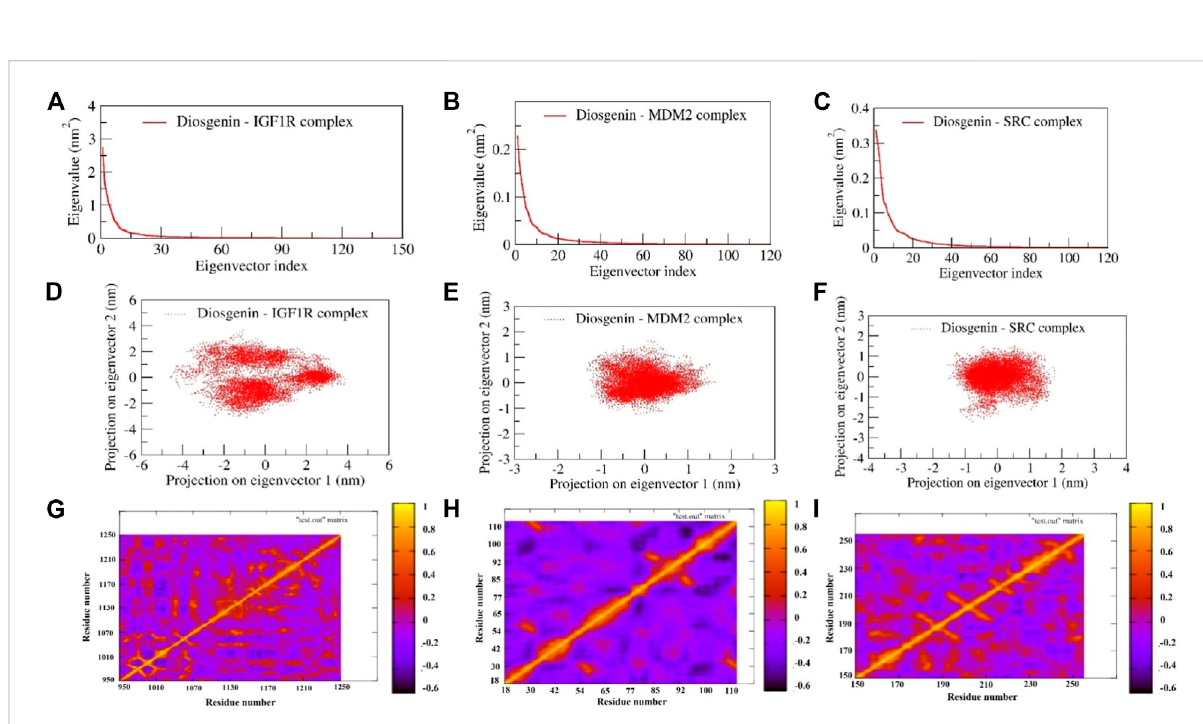
FIGURE 11 Represents the principal component analysis and dynamic cross-correlation matrix of complexes: The fi rst 120 eigenvectors were plotted v/s eigenvalues for diosgenin with (A) IGF1R (B) MDM2 , and (C) SRC . The collective motions of diosgenin with (D) IGF1R (E) MDM2 , and (F) SRC using projections of MD trajectories on two eigenvectors corresponding to the fi rst two principal components. Dynamic cross-correlation matrix of C α atoms observed in diosgenin with (G) IGF1R (H) MDM2 , and (I) SRC . The amber-colored positive regions re fl ect strongly correlated C α atom movements (C ij = 1), whereas the blue-colored negative regions show anticorrelated motions (C ij =